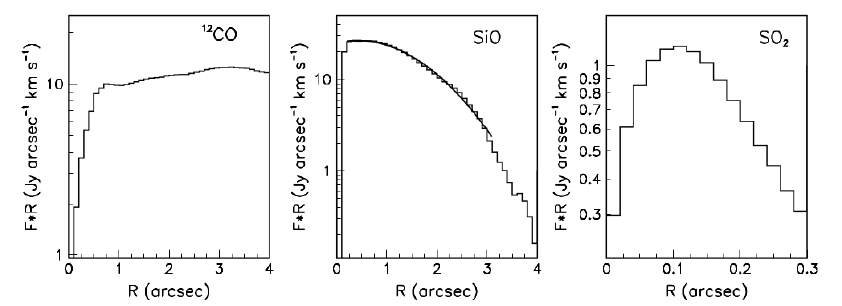
Figure 1 : EP Aqr: Dependence on R of the intensity multiplied by R for CO, SiO and SO 2 (from left to